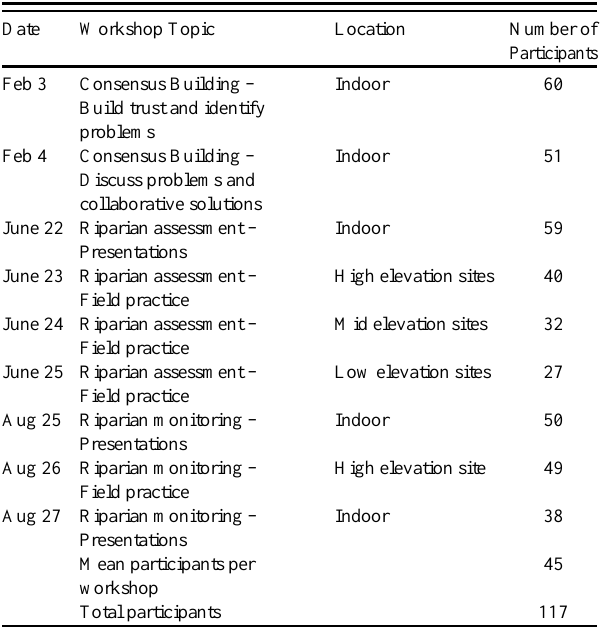
Table 1 . Dates, locations, and number of participants for the series of riparian workshops held on the Sprucedale NF in 2009. Transcripts from the June 23 workshop were used for in-depth analysis in this